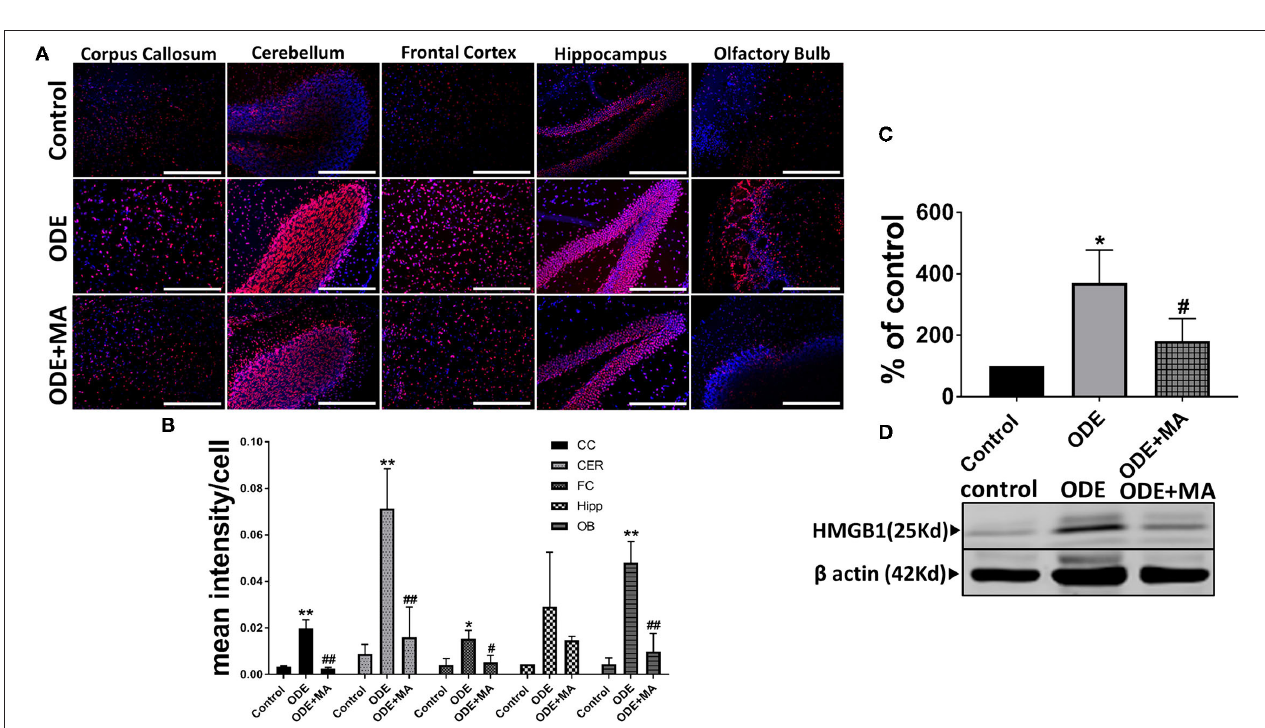
FIGURE 1 | paraformaldehyde) mice brain and decalcified upper respiratory tract are shown (A–C) . Compared to control, Fluorescent LPS (white arrowhead) was observed in nasal turbinate and the olfactory bulb of the brain ( A : i–iv, micrometer bar = 100 µ m, 20x). When compared to control, mice exposed to ODE showed atrophic changes in the olfactory epithelium (double sided arrow) and fewer nerve bundles (black arrowhead) in nasopharyngeal meatus. Mitoapocynin (MA) treatment partially rescued olfactory epithelium atrophy and nerve bundle loss ( B : i–iii, micrometer bar = 100 µ m, 20x). Immunofluorescent staining of the nasopharyngeal meatus (coronal sections) with acetylated α -tubulin showed a significant loss of cilia (white arrow) in mice treated with ODE ( C : i–iii, micrometer bar = 100 µ m, 20x), and MA treatment had no effect on cilia loss ( C : vii). Goblet cell numbers and nasal epithelium thickness (two-sided arrow) were analyzed by a blinded investigator ( C : iv–vi, micrometer bar = 50 µ m, 40x). Compared to control, ODE exposure induced goblet cell hyperplasia and thickening of the nasal epithelium, and MA treatment had no effect ( C : viii, ix). Upon visual gross examination of freshly dissected non-perfused brains, ODE-exposed mice showed signs of congestion when compared to